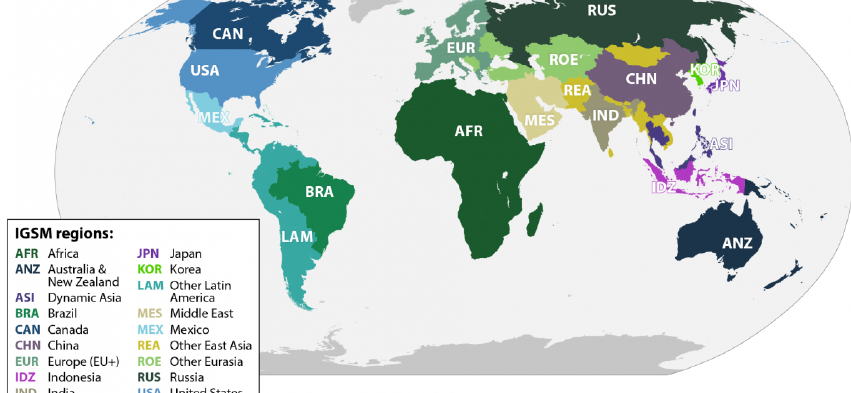
Figure B1. Map of EPPA7 regions of the world, from Paltsev et al. (2021) and online documentation of its Integrated Global System Modeling (IGSM) framework (https://globalchange.mit.edu/research/research-tools/eppa, last access: 5 October 2022) with reproduction rights